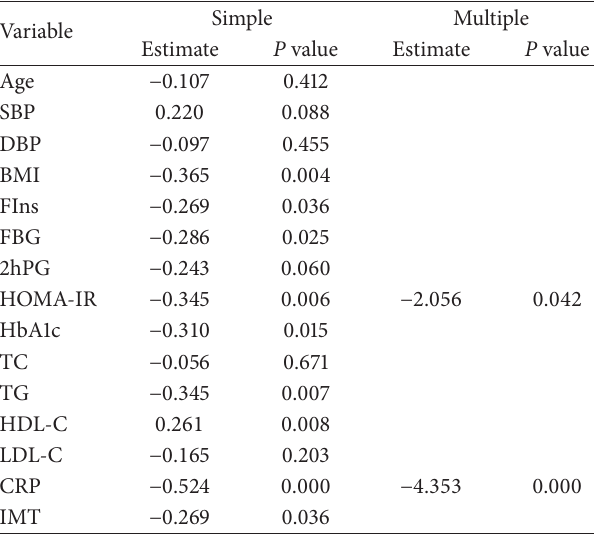
Table 3: Correlation analysis of variables associated with IMT in subjects